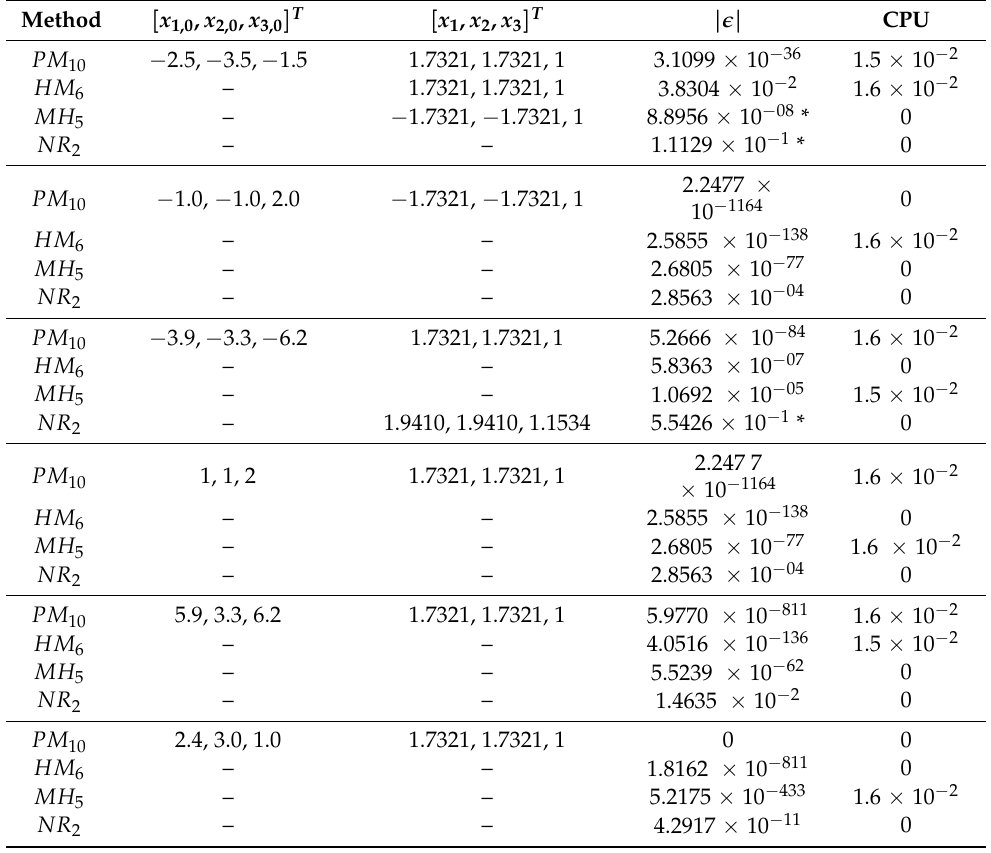
Table 16. Numerical results for problem 11 with ∗ showing the divergence of the